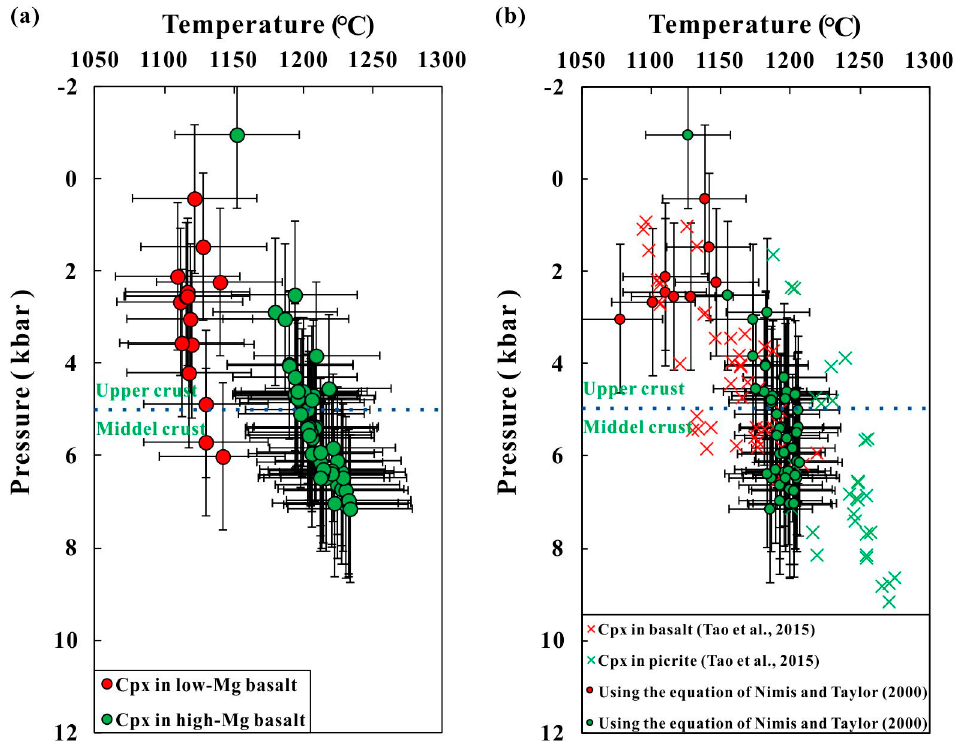
Figure 9. Cpx equilibrium pressures and temperatures calculated by chemical thermobarometry. Each sign denotes data point from Cpx phenocryst-matrix pair. (The error bars in a and b show the SEE of the geothermometer methods from Putirka, 2008 [22] and Nimis and Talyor (2000) [82], respectively). ( a ) P-T calculation based on the model of Putirka, 2008 [22]; ( b ) P-T calculation based on the model of Nimis and Talyor (2000) [82].